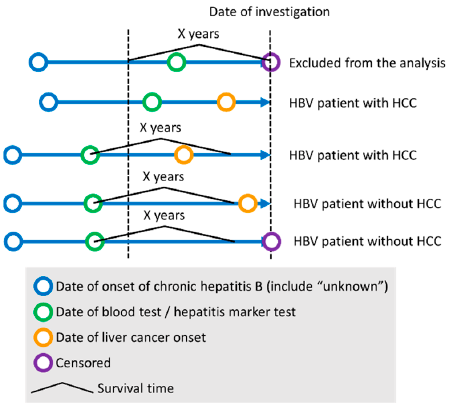
Figure 3. Study design of ROC analysis for HCC onset within X years.